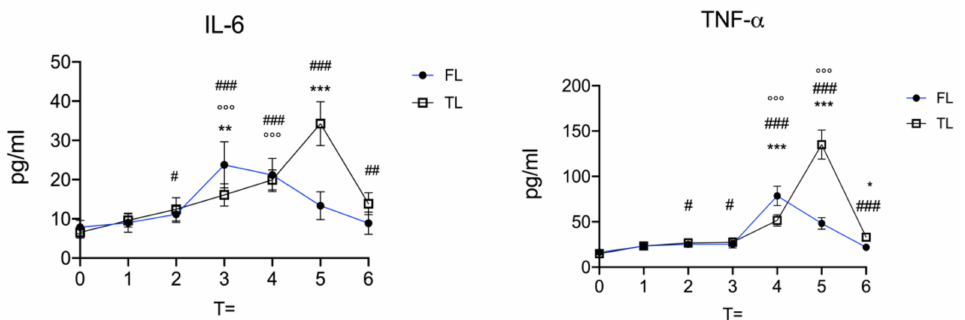
Figure 3. Timeline of IL-6 and TNF- α plasmatic levels measured by ELISA assay. FL, funicular group; TL, testicular group. All values are shown as the mean ± standard deviation (SD) of N observations (N = 8) for each group. # p < 0.05 versus T = 0 of TL group; ## p < 0.01 versus T = 0 of TL group; ### p < 0.001 versus T = 0 of TL group; ◦◦◦ p < 0.001 versus T= 0 of TL group; * p < 0.05 FL versus TL; ** p < 0.01 FL versus TL; *** p < 0.001 FL versus